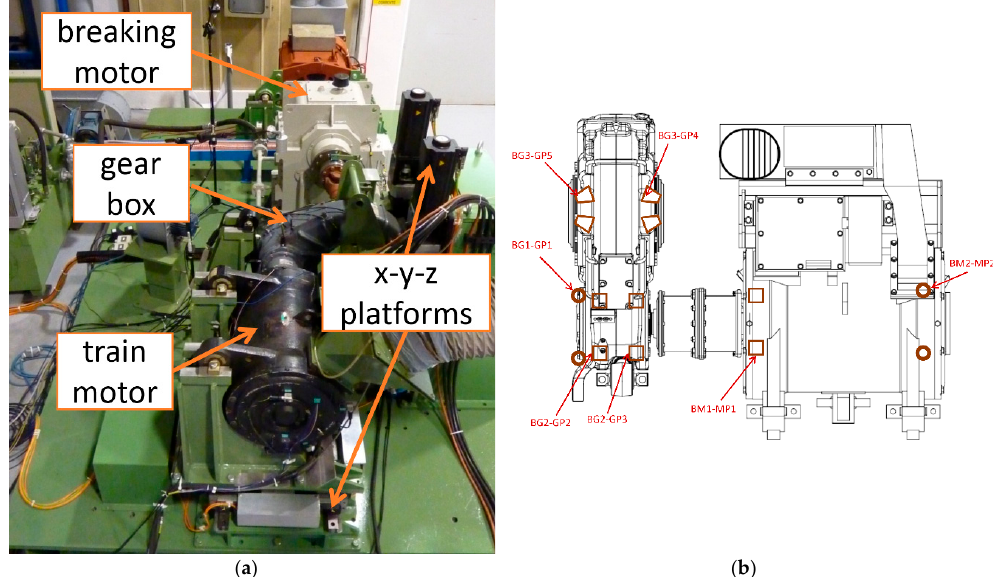
Figure 7. ( a ) The test ‐ rig system; ( b ) The core schematic of the system.